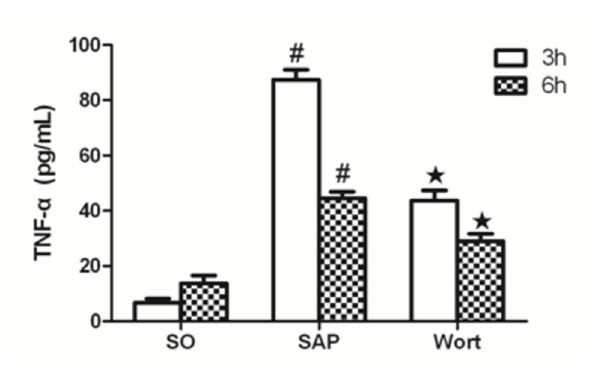
Figure 4. TNF-α level in each group at the 3 h and 6 h time point. # P <0.05 vs. SO group; ★ P <0.05 vs. SAP group.